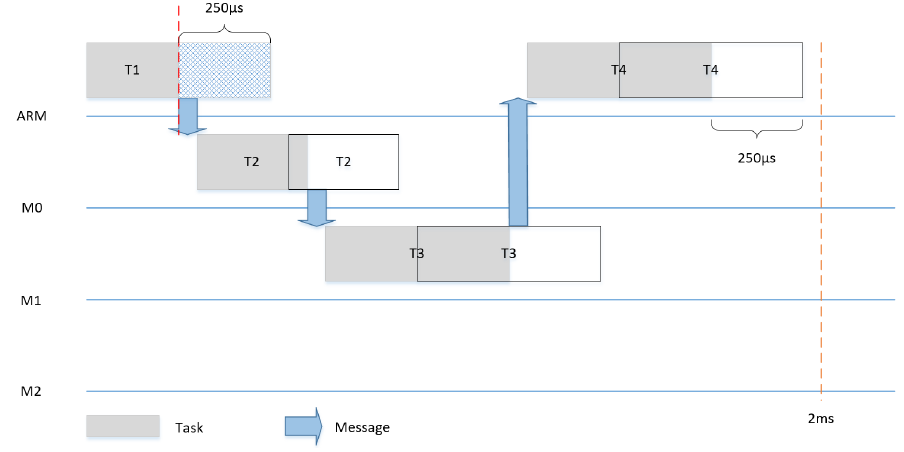
Figure 14. Example for slack in Task T1 of Scenario